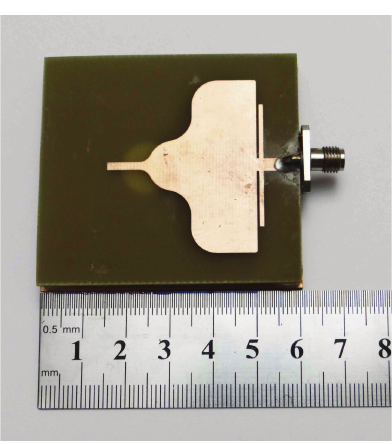
Figure 9: Fabricated antenna.